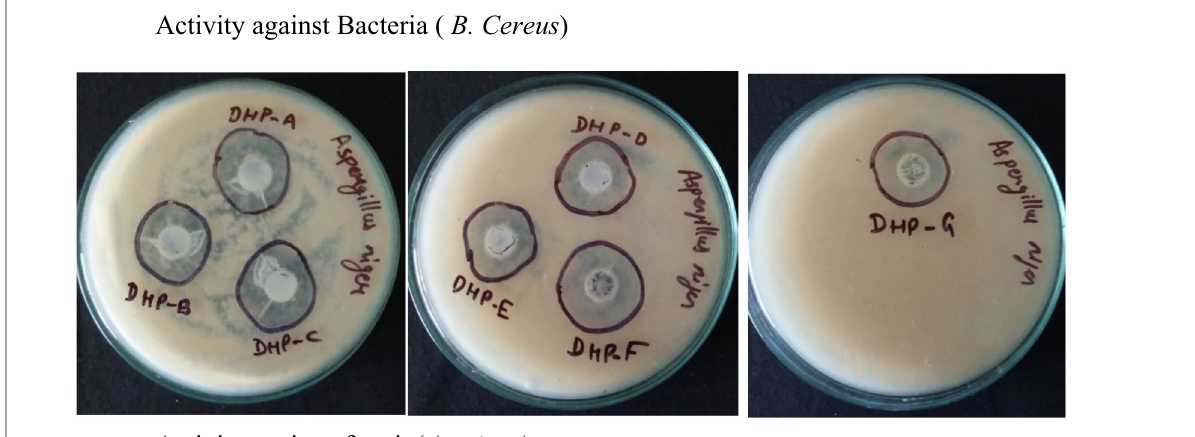
Table S3. The role of Cys 42 residue in the inhibition of